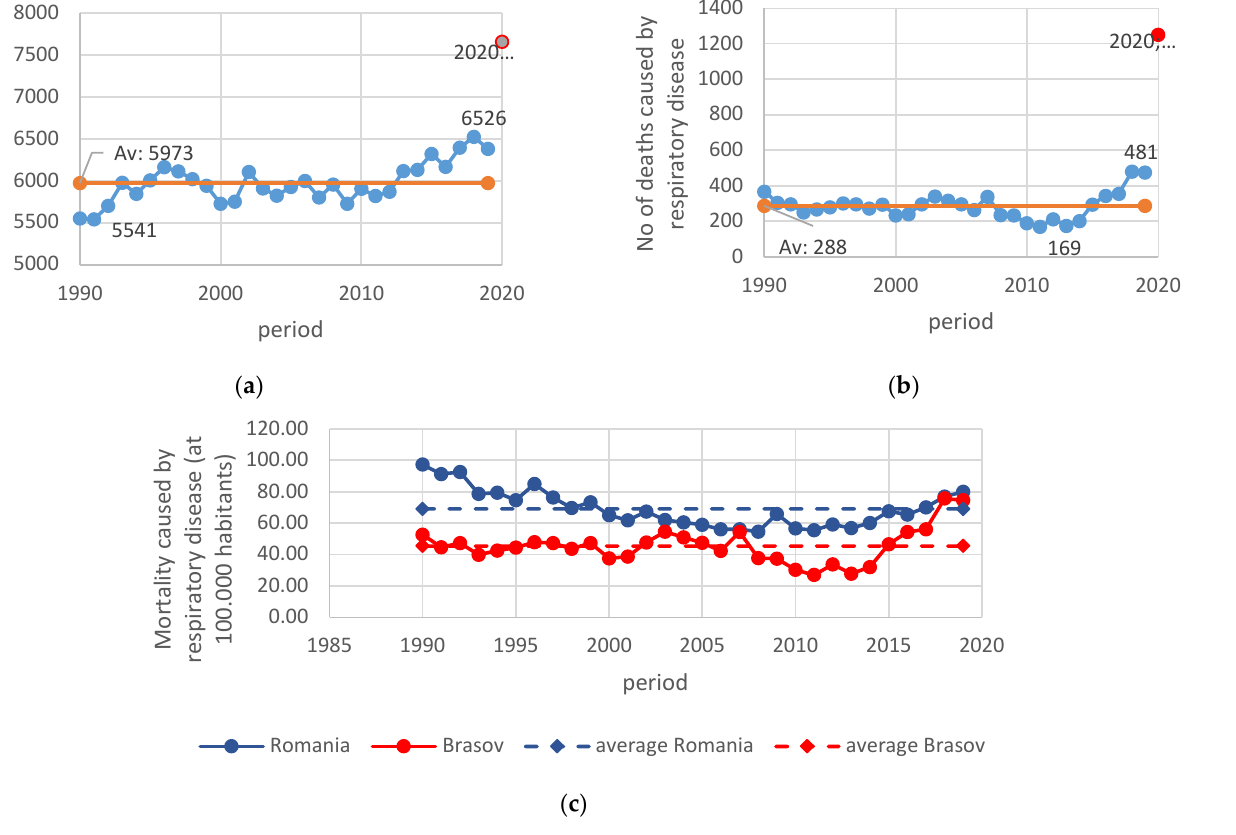
Figure 4. The evolution of the number of deaths and SDR in Brasov County ( a ) Number of total deaths; ( b ) Number of deaths caused by respiratory diseases; ( c ) SDR caused by respiratory diseases.